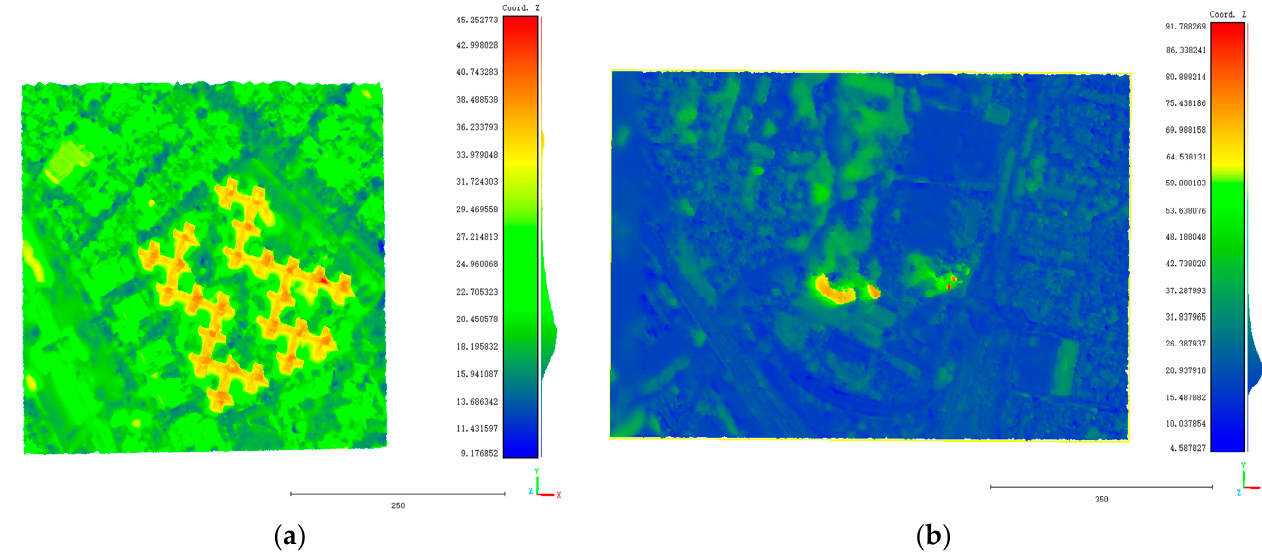
Figure 11. Results of refinement: ( a ) test site 1, ( b ) test site 2.